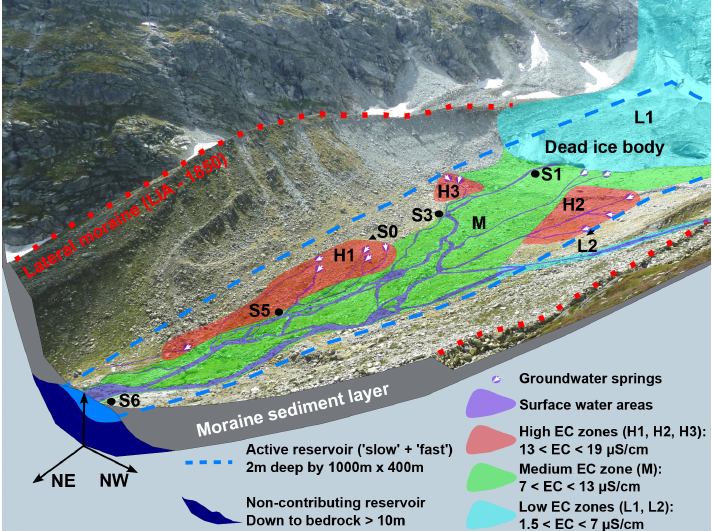
Figure 7. Conceptual summary of the forefield’s hydrogeology. The stream network is drawn, as well as the main groundwater springs where electrical conductivity was measured and all electrical conductivity zones. A tentative outline of the active reservoir (“slow” + “fast”) is proposed. The discharge station S7 is not displayed as it is slightly outside of the side cut. The lateral moraines are shown by red dotted